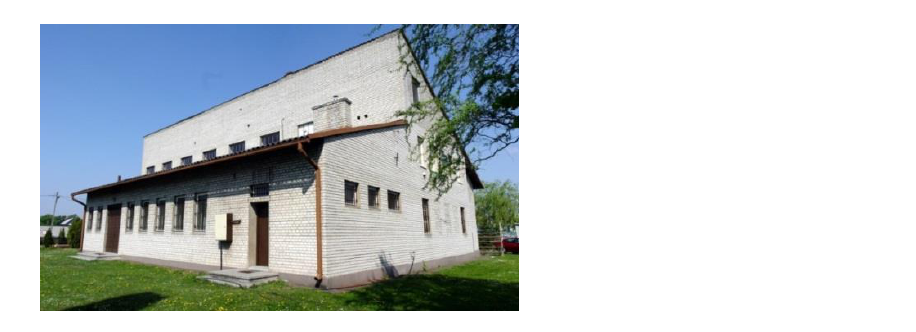
Figure 12. Church of the Immaculate Heart of the Blessed Virgin Mary in Czarny Las (built in 1984–88).